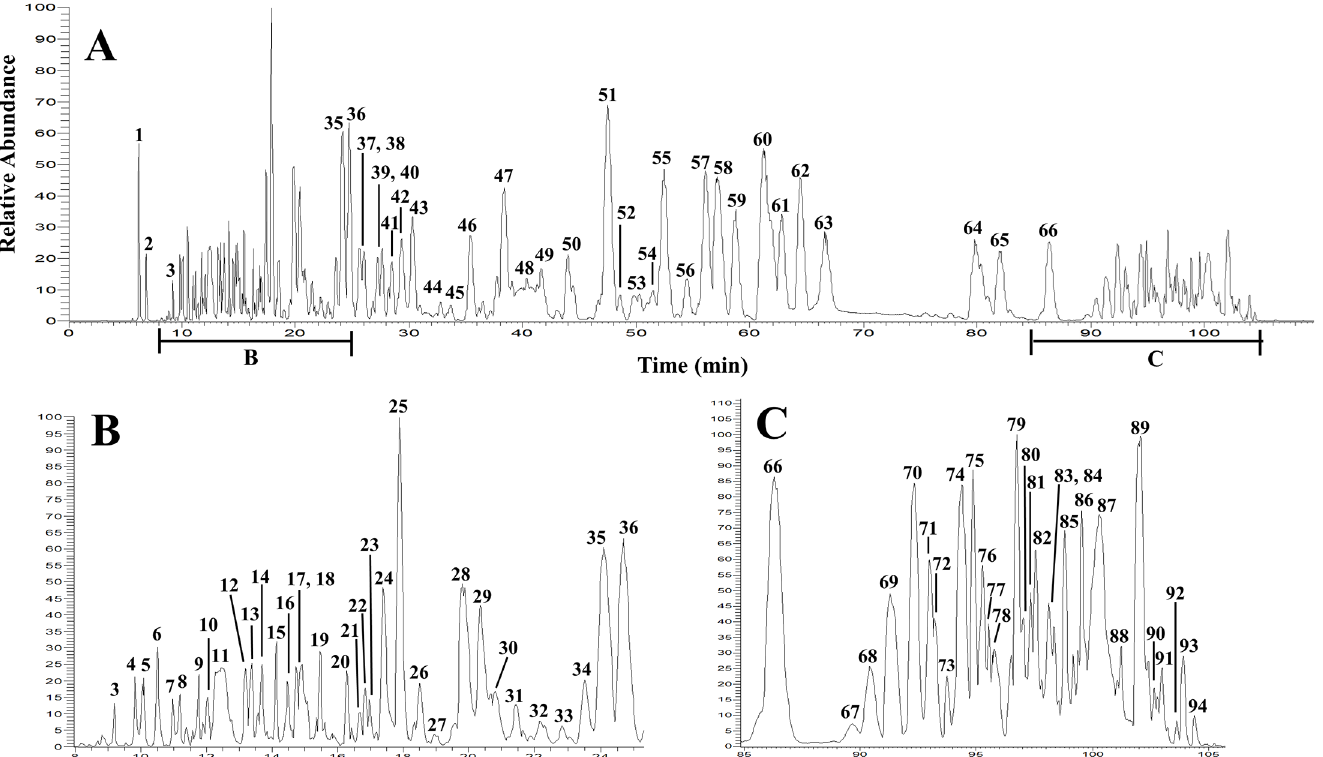
Fig 9. LC-FTMS ESI negative base peak chromatogram for 224C-F2. All peaks correspond to data presented in Table 5. Putative structures are reported in Fig